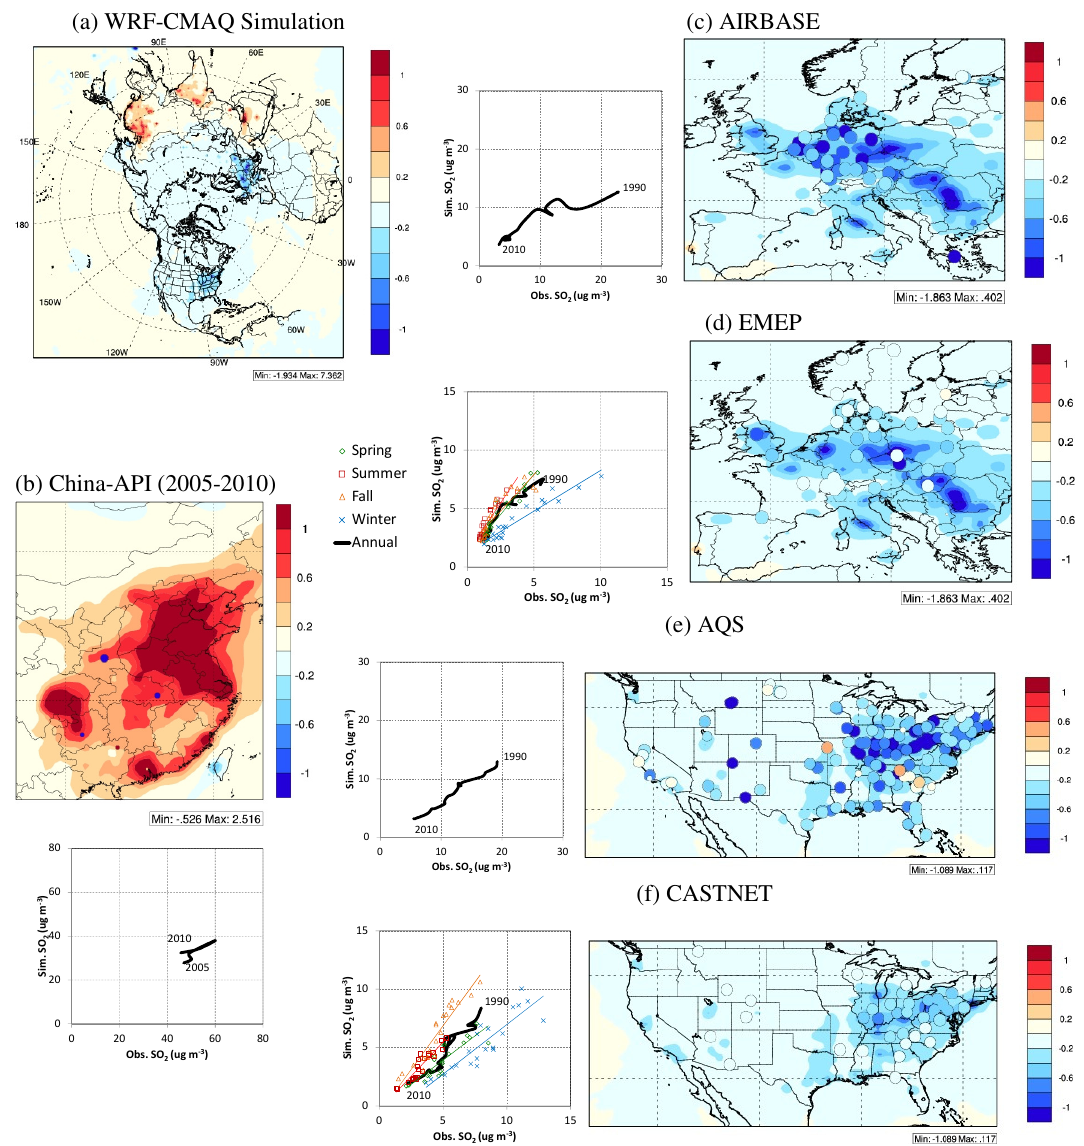
Figure 3. (a) simulated SO 2 trend from WRF-CMAQ (µgm − 3 yr − 1 ) ; (b) map: simulated SO 2 trend in eastern China overlaid with observed SO 2 trends from China-API, dots represent each observation site, computed on the basis of annual means over the 2005–2010 period with a linear least square fit method, dot size is determined by the significance of the trend, i.e., larger symbols denote more significant trends at the p = 0.05 level (µgm − 3 yr − 1 ) ; scatterplot: observed and simulated SO 2 concentration, network mean for each year’s corresponding grid cells from the model simulation are selected for comparison (µgm − 3 ) ; (c) same as (b) for EU-AIRBASE; (d) same as (b) for EU-EMEP; (e) same as (b) for the US-AQS; (f) same as (b) for the US-CASTNET.